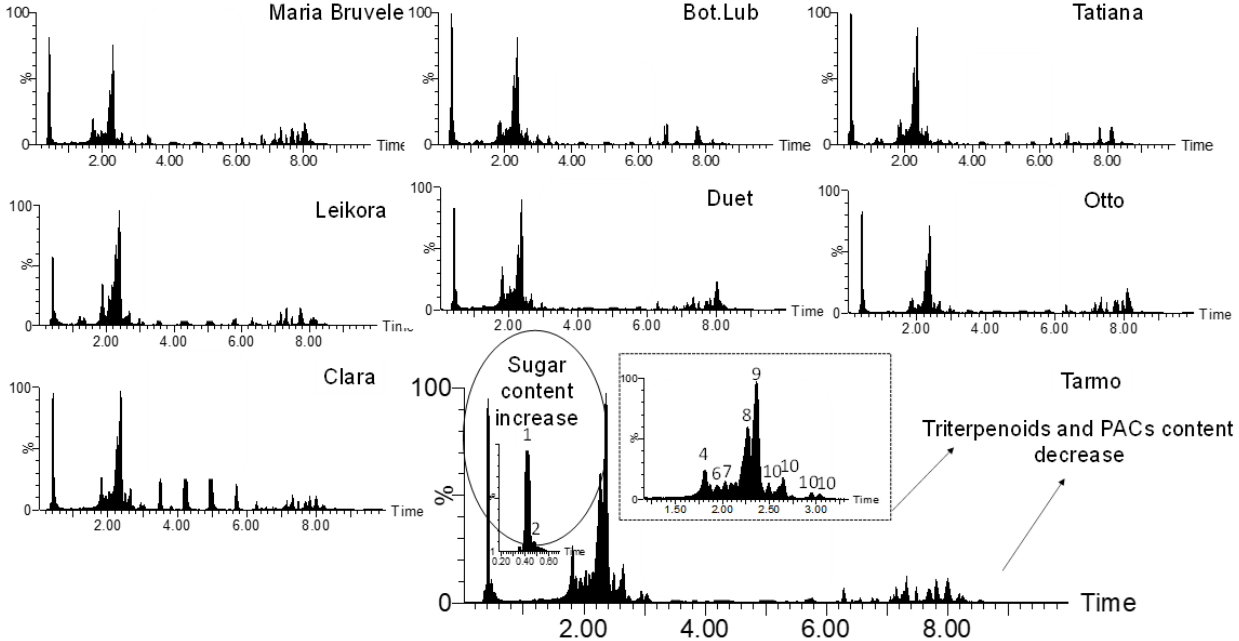
Figure 4. Comparison of the chemical composition of the sea buckthorn water extracts by UHPLC- TOF/MS chromatograms.